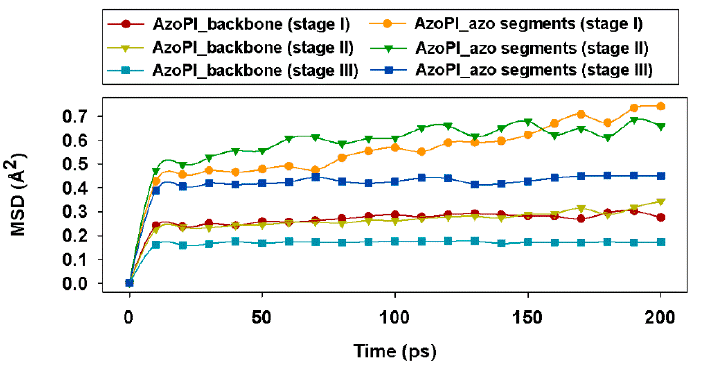
Figure 10. Evolution in time of the mean square displacement function of the AzoPI backbones and corresponding azo segments in stage I, stage II, and stage III.